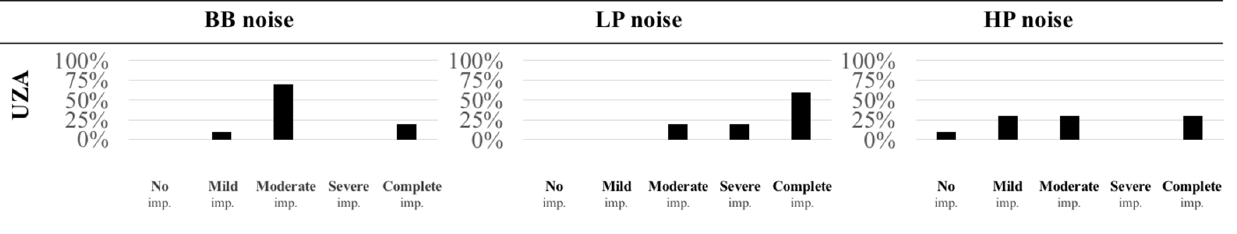
Figure 5. Application of the HEARRING_LOC_ICF scale on data from the Antwerp University Hos- pital (UZA) for two different listener groups, a single-sided deaf group (SSD) and a group with asymmetric hearing loss (AHL), retrieved from Mertens et al. [24]. Histograms are presented with the distribution of the observed localization impairment for the two different groups. 4. Discussion Sound localization is an important aspect of hearing, and its preservation or restora- tion is a major goal of hearing implant technologies. Sound localization measurement is commonly performed both in the assessment of the rehabilitation of hearing implant us- ers, as well as in psychophysical research to improve hearing implant performance. Across institutions, there exist major variations in localization assessment. These include variations in the testing procedure as well as in the statistical and reporting metrics used. A standardized testing procedure has been reported elsewhere [29]; however, the latter source of variation remains an issue within the audiological community. Here, the HEAR- RING group proposes a standardized classification system based on the ICF framework. The ICF framework is endorsed by the WHO and is used worldwide as the standard for measuring and describing health and disability (World Health Organization, 2001). There- fore, it provides a common language to define different perspectives of health (biological, psychological, and social) on an individual level, focusing on consequences of health con- ditions rather than causes. Using this common language, one is able to investigate the effect of an intervention (such as cochlear implantation) on different perspectives of hear-